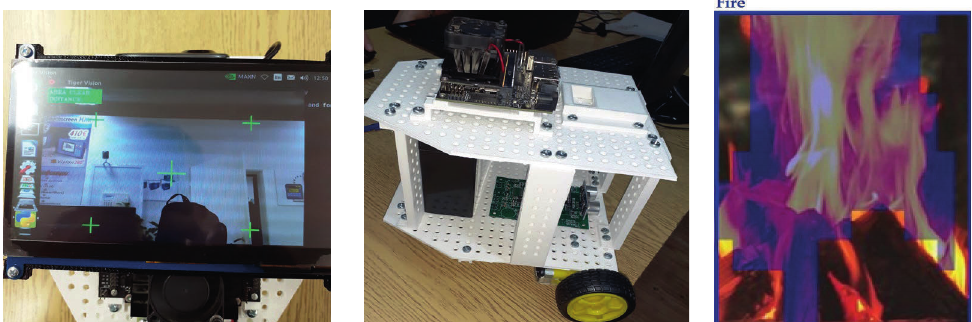
Fig. 2. A robot that detects flames using deep neural networks and an example of detection with good fire contrast to the surrounding